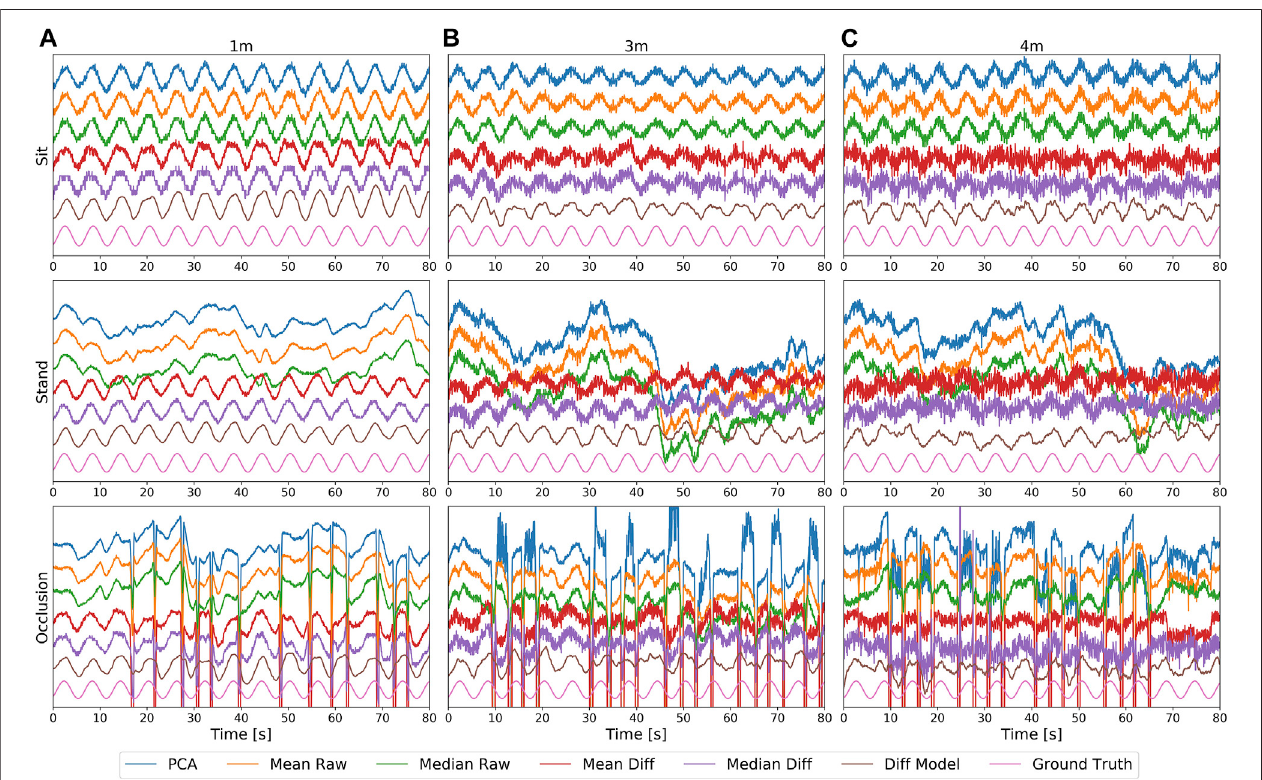
FIGURE 4 | The respiration signals from the methods PCA, Mean Raw, Median Raw, Mean Diff, Median Diff, and Diff Model, as well as the ground truth, obtained fromthechestatadistanceof1 m (A) ,3 m (B) ,and4 m (C) fortheconditionssitting (top) ,standing (middle) ,andstandingwithocclusion (bottom) .Allsignalsarezero centered and normalized with respect to the mean and standard deviation of their fi rst 240 frames (8 s) and, for better visibility, are stacked vertically in the order as mentioned above. With increasing distance, the noise level of all methods increases. The Diff Model hereby is the least affected method and the other difference based methods are affected the most. Standing introduces signi fi cant signal distortions for non-difference based methods. Occlusion events, visible as large spikes in the bottom plots, can only be handled by the Diff Model method.